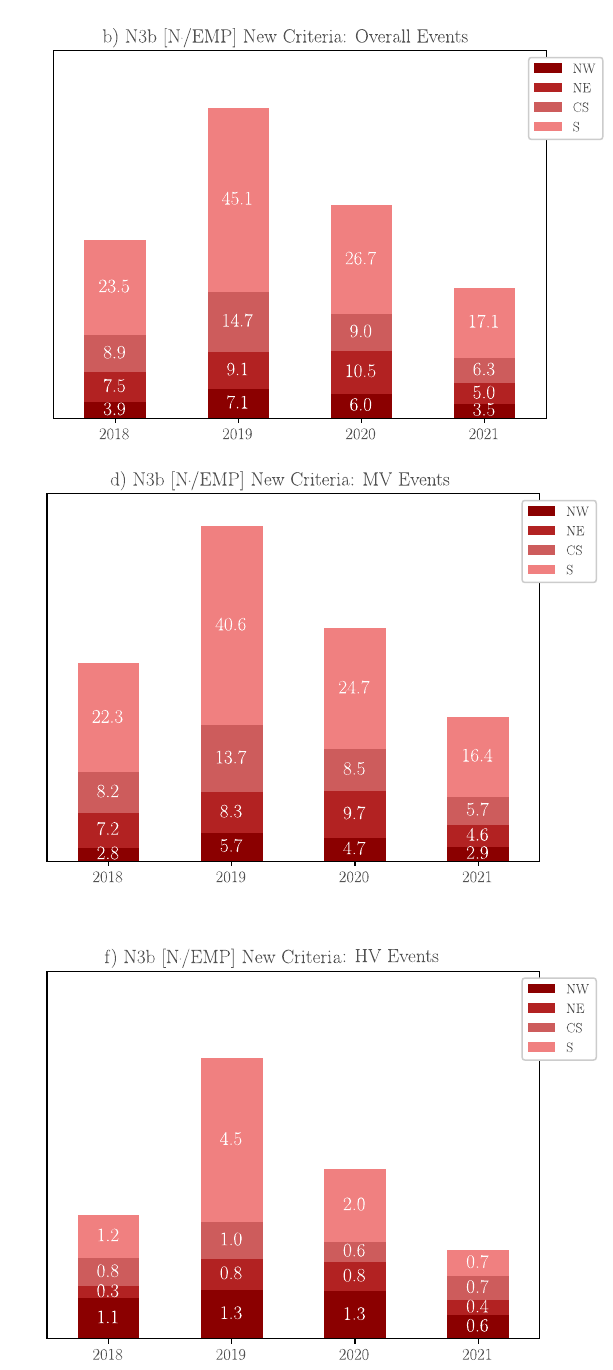
Figure 15. ( a ) current criteria N3b: overall events; ( b ) new criteria N3b: overall events; ( c ) current criteria N3b: MV events; ( d ) new criteria N3b: MV events; ( e ) current criteria N3b: HV events; ( f ) new criteria N3b: HV events.